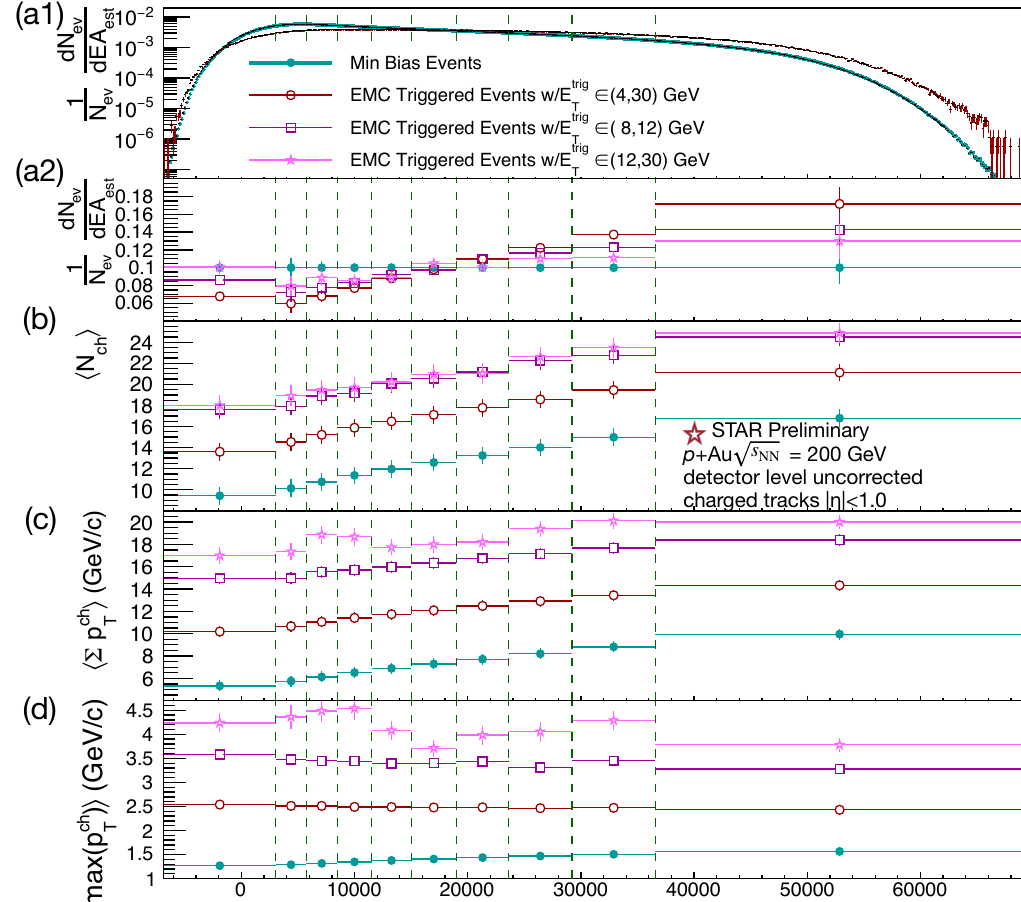
Figure 2. Correlations between charged tracks at STAR ( | η | < 1) and EA est , the Au-going BBC inner ring signal ( | η | ∈ ( 3.3,5.8 ) ). Each panel is plotted with data from MB events as well EMC E trig events. ( a ) The number of events of each BBC bin; each bin’s boundaries are selected to contain 10% of the MB data. ( b ) Average number of charged tracks per event. ( c ) Average sum of p T per event. ( d ) Average maximum track p T per